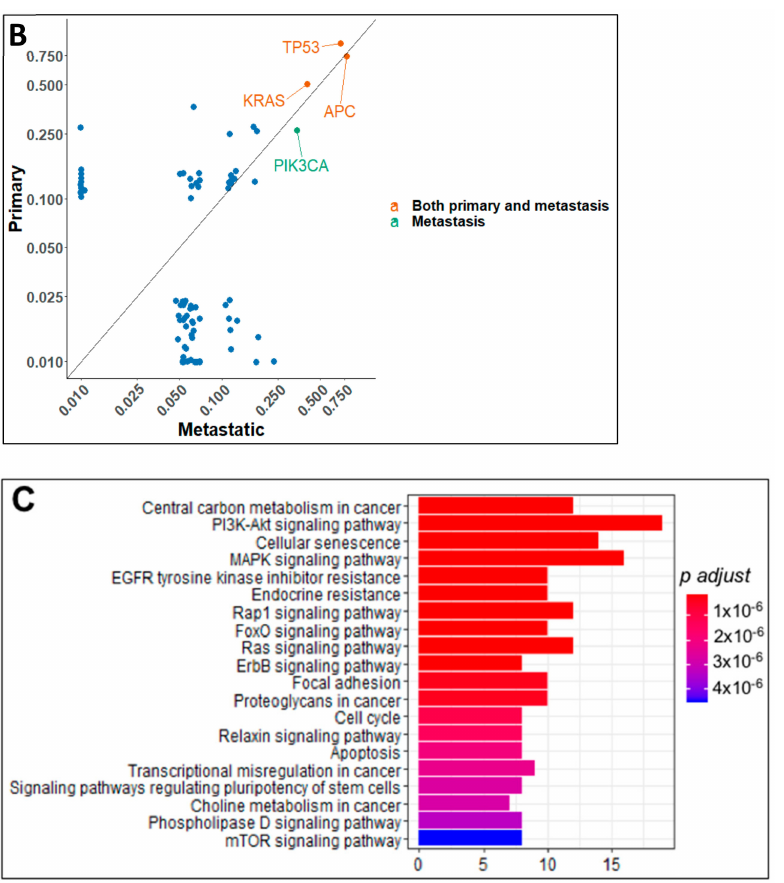
Figure 4. ( A ) Map of mutation frequencies (F) in colon cancer patients with adenocarcinoma histology type. “Gene” node sizes positively correlate with gene mutation frequency. Pink-colored gene nodes: genes mutated in multiple primary/metastatic sites. Gray-colored gene nodes: mutated genes unique to the particular primary/metastatic site. ( B ) Plot of relative frequency of gene mutations in primary and metastatic and gene enriched are highlighted. ( C ) Signaling pathways altered by significant gene mutation. Genes with significant mutations were analyzed for enrichment of Kegg pathways. Pathways with adjusted p value < 0.05 were selected. The bar plot shows the significant pathways with bar height as gene